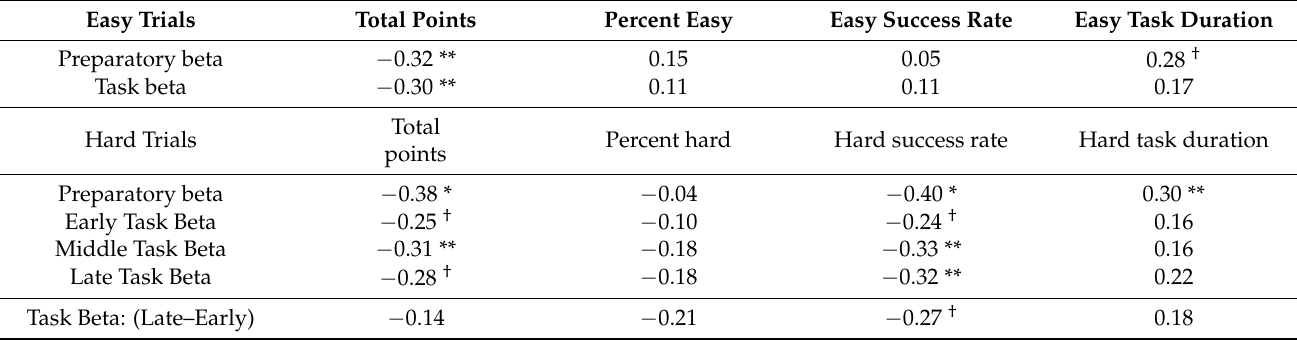
Table 1. Correlations between beta activation and behavioral outcome variables during easy and hard trials. Beta activation is shown separately for the preparatory phase and the task execution phase. Due to the relatively short length of easy trials, the task execution phase is listed as one segment. The task execution phase of hard trials is divided into thirds: early, middle, and late. The difference between the late and early thirds is also represented for hard trials.